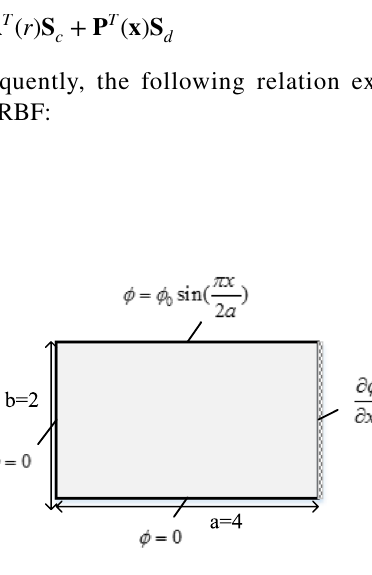
Fig. 2 Domain and different boundary conditions for validation prob- lem